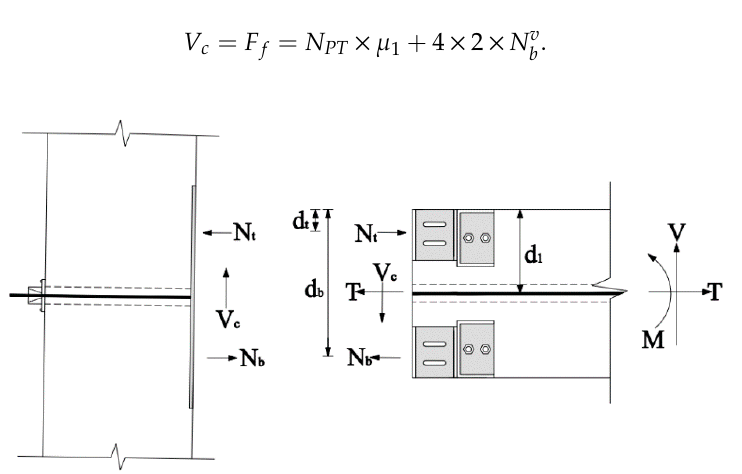
Figure 7. Theoretical hysteretic model of the novel SCPC connection.